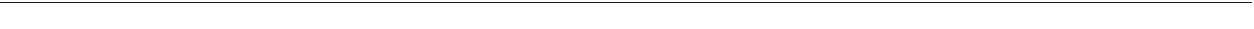
Fig. 2 Zscan4 is expressed in human lung tumour stroma after chemotherapy and correlated with poor survival statistics. a Histological assessment of Zscan4 in primary tumour tissues of NSCLC patients. Arrows in the IHC image, intensive nuclear signals of Zscan4 in stroma. Scale bars, 50 µ m. Cisplatin was used as a chemotherapeutic agent for the treated patient. b Pathological appraisal of stromal Zscan4 expression in NSCLC samples. Patients were individually assigned into 4 categories per IHC staining intensity of the stroma. 1, negative; 2, weak; 3, moderate; 4, strong expression. Left, statistical comparison. Right, representative images. ES, expression level. Scale bars, 50 µ m. Data analyzed by two-way ANOVA. c Boxplot summary of Zscan4 transcript expression by qRT-PCR analysis upon laser capture microdissection of cells from tumour and stroma, individually from samples of 10 randomly selected patients. d Zscan4 expression at transcription level in stromal cells collected before versus after chemotherapy of the same individuals. e Kaplan – Meier analysis of NSCLC patient. Disease free survival (DFS) strati fi ed according to Zscan4 expression. DFS represents the length (months) of period calculated from the date of NSCLC diagnosis to the point of fi rst time disease relapse. Data compared with log-rank (Mantel – Cox) test. f Pathological correlation between Zscan4, p38, and mTOR in the stroma of NSCLC patients post treatment. Columns represent individual patients, rows different molecules. Totally 99 patients treated by chemotherapy were analyzed. Bottom, representative IHC images of Zscan4, p38 (T-180), and mTOR (S-2448), respectively. P < 0.0001 for score-score matching by two-way ANOVA. g Statistical correlation between Zscan4 and p38 scores in the 99 tumours with matching protein expression data. h Statistical correlation between Zscan4 and mTOR scores in the same group of tumours described in f . i Statistical correlation between Zscan4 and caspase 3 (cleaved) scores in the same group of tumours described in f . j Data in all bar plots are shown as mean ± SD and representative of 3 biological replicates. Data in c , d were analyzed using Student ’ s t -test.* P < 0.05, ** P < 0.01, *** P < 0.001, ^ P >